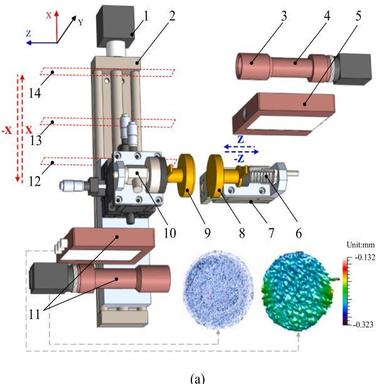
Schematic of the experimental system. (a) Test rig (1—Stepping motor, 2—Electric slider, 3—Ring illuminator, 4—CCD camera (scanning system 1), 5—3D optical surface profiling (scanning system 1), 6—Spring, 7—Electric actuator, 8—Movable electrode, 9—Stationary electrode, 10—Dynamic force transducer, 11—Scanning system 2, 12—Electrode pairs switching position, 13—3D measurement position, 14—2D measurement position.). (b) Experimental circuit.